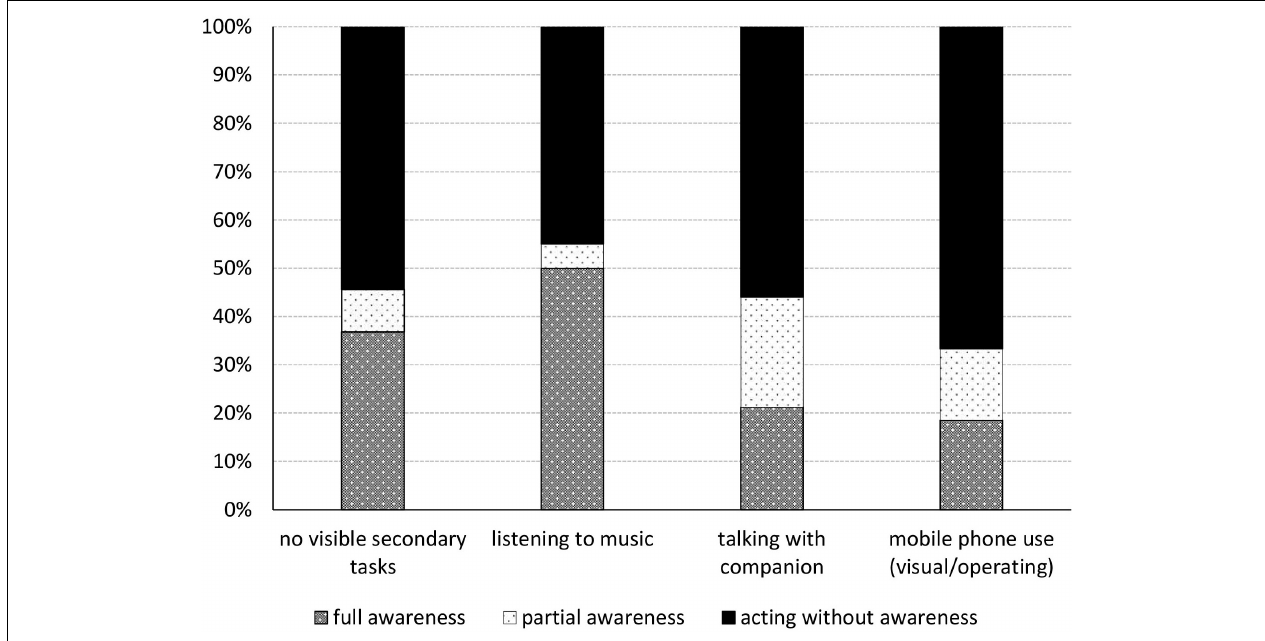
FIGURE 3 | Participants’ level of awareness for the signboard while being engaged in various overt secondary tasks. Engagement in any overt secondary task (or the lack thereof) differed significantly for full awareness ( p = 0.018). When tallying full and partial awareness these differences disappeared ( p = 0.508).